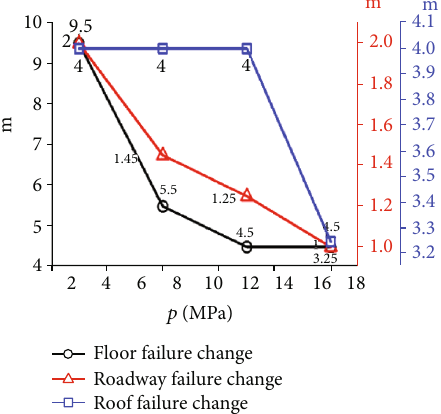
Figure 10: The damage depth of the surrounding rocks corresponding to the spherical